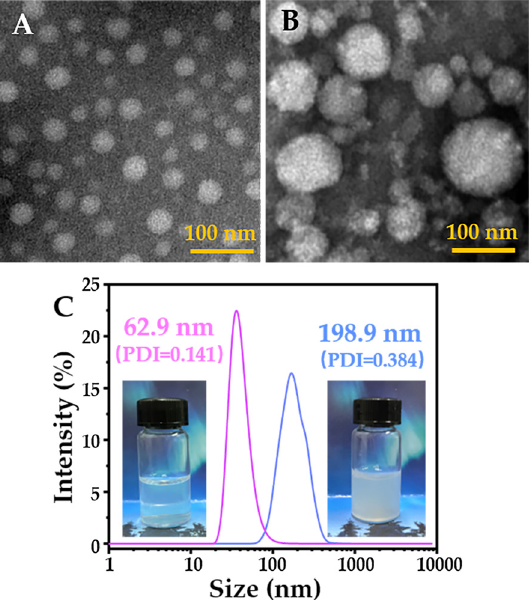
Figure 3. Morphologies (TEM) and particle size distributions (DLS) of PCL- b -pSMA micelles in the aqueous phase (0.3 mg mL − 1 ) with different pH values: ( A ) TEM result of PCL- b -pSMA micelles in the buffer with a physiological pH value (pH = 7.43); ( B ) TEM result of PCL- b -pSMA micelles in neutral buffer (pH = 7.05); ( C ) DLS results of the samples in ( A , B ).